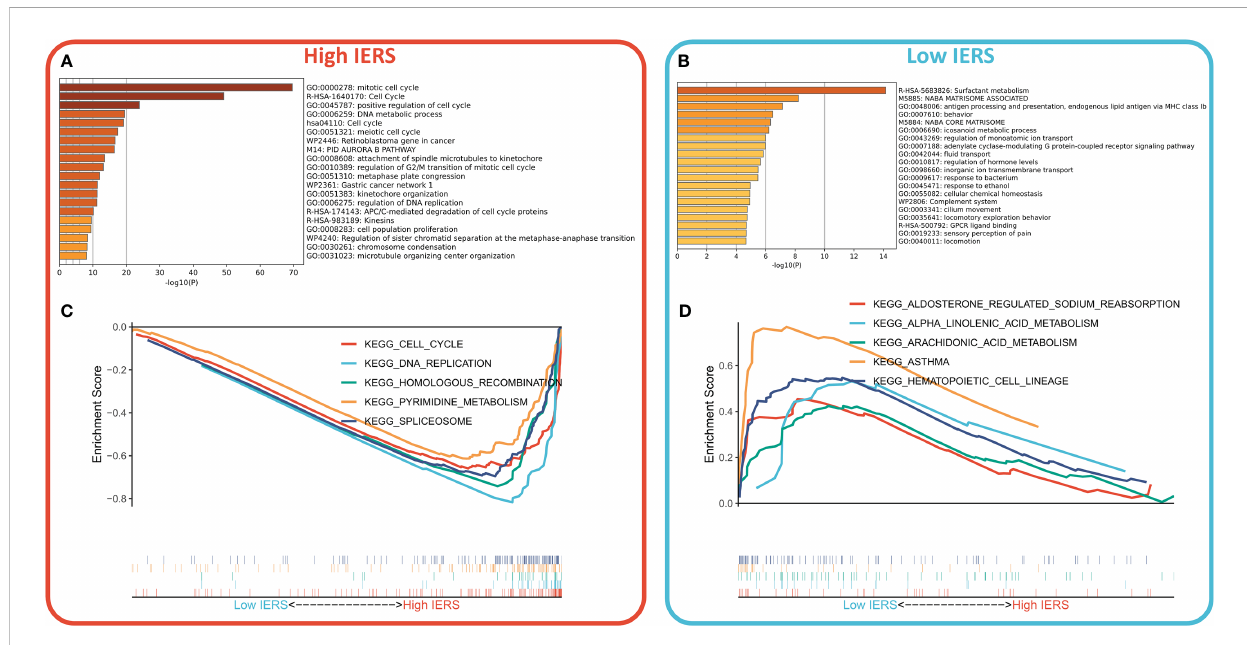
FIGURE 5 Functional analysis for IERS (A) Bar plot showed the biological pathways of upregulated gene enrichment in the high IERS group. (B) Bar plot showed the biological pathways of upregulated gene enrichment in the low IERS group. (C) GSEA analysis revealed the top fi ve enriched KEGG pathways in the high IERS group. (D) GSEA analysis revealed the top fi ve enriched KEGG pathways in the low IERS